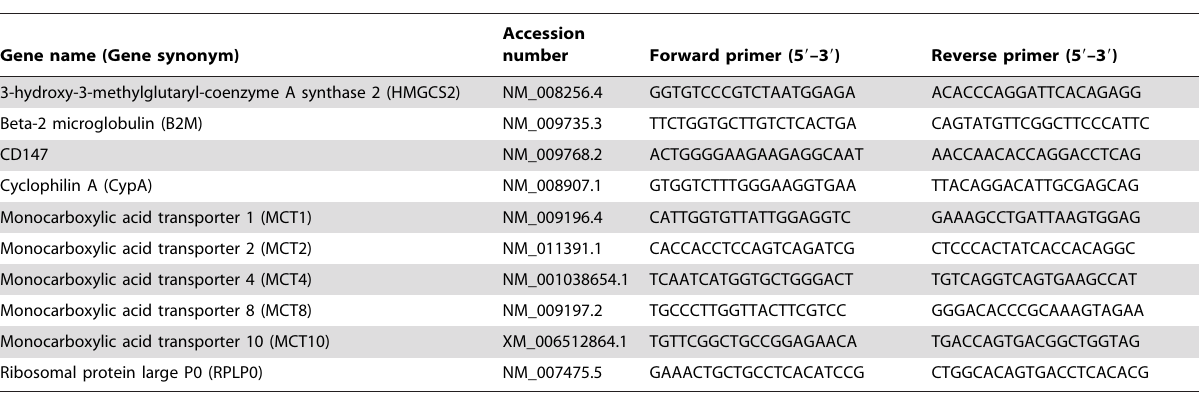
Table 1. Primer sequences used in real-time